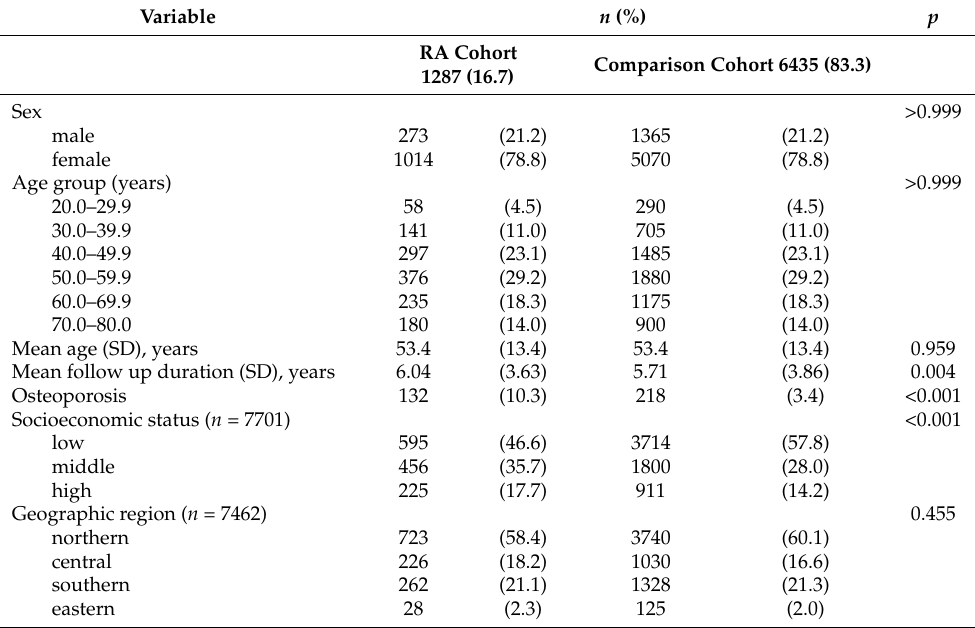
Table 1. Basic characteristics of the patients in the rheumatoid arthritis cohort and the comparison cohort ( n = 7722).